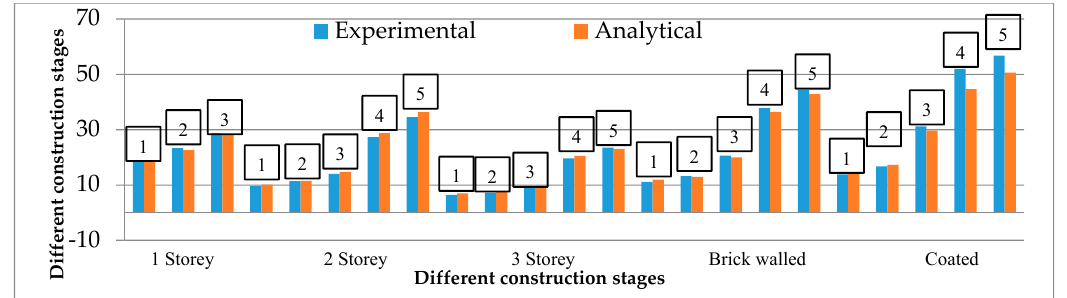
Figure 4. Comparison between natural frequencies for construction stages.